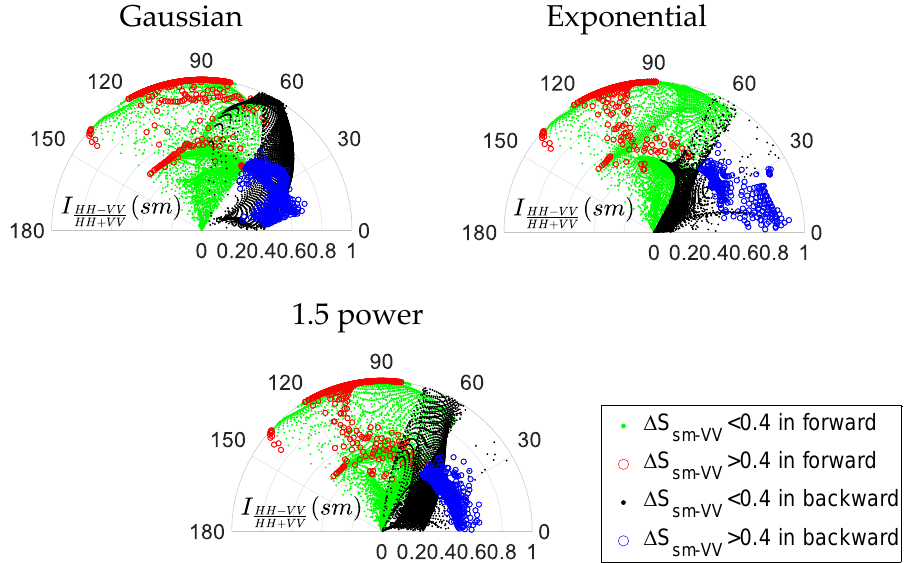
Figure 11. Distribution of quality index versus bistatic angle.